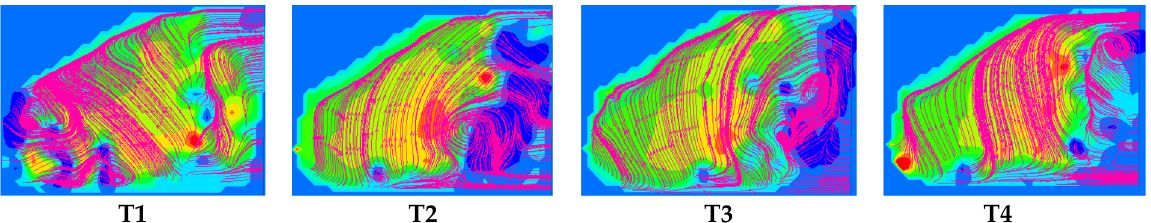
Figure 11. Developed vortex conditions at high unit speeds. T1–T4 is the moment of shooting.